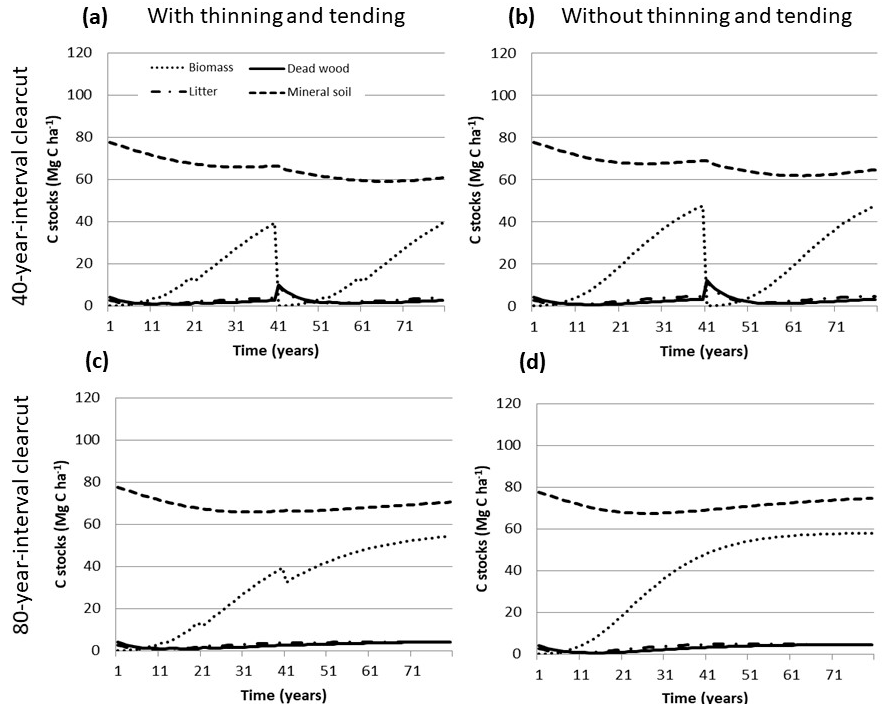
Figure 2. Carbon stock scenarios resulting from the application of the Forest Biomass and Dead organic matter Carbon (FBDC) model for low biomass production forests in South Korea according to ( a , b ) and ( c , d ) cutting age (40 and 80 years) and ( a , c ) and ( b , d ) with and without thinning and tending during the first 80 years after implementing the forest management. Different line types represent different forest carbon pools (biomass, litter, dead wood, and mineral soil).